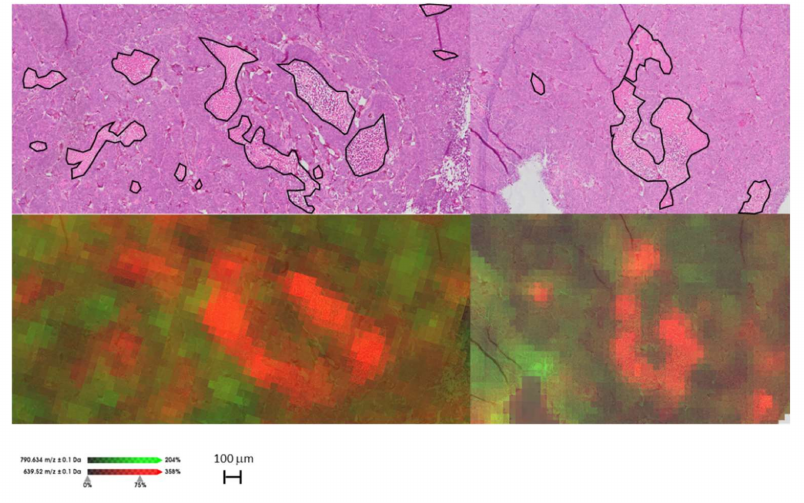
Figure 1. Example of MALDI-MSI ion maps compared with HES staining of the same tissue after MALDI MSI measurement. The distribution of the ions at m/z 790.6 (green) and 639.5 (red) distinguish tumor and necrotic regions, respectively. Necrotic areas are marked with